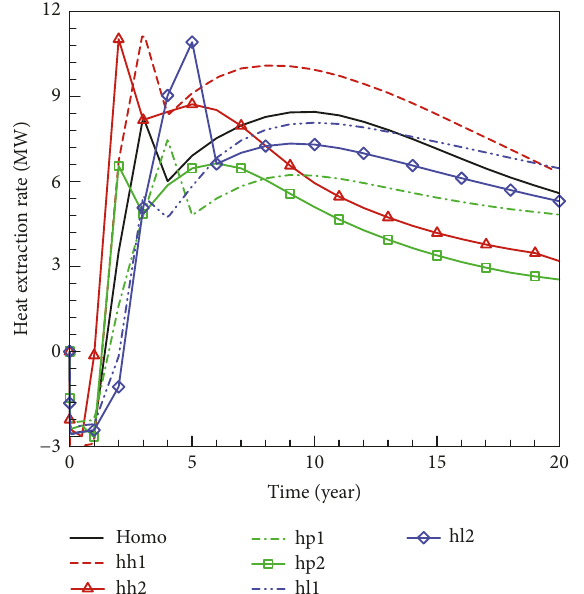
Figure 11: Variation of heat extraction rate over time for different